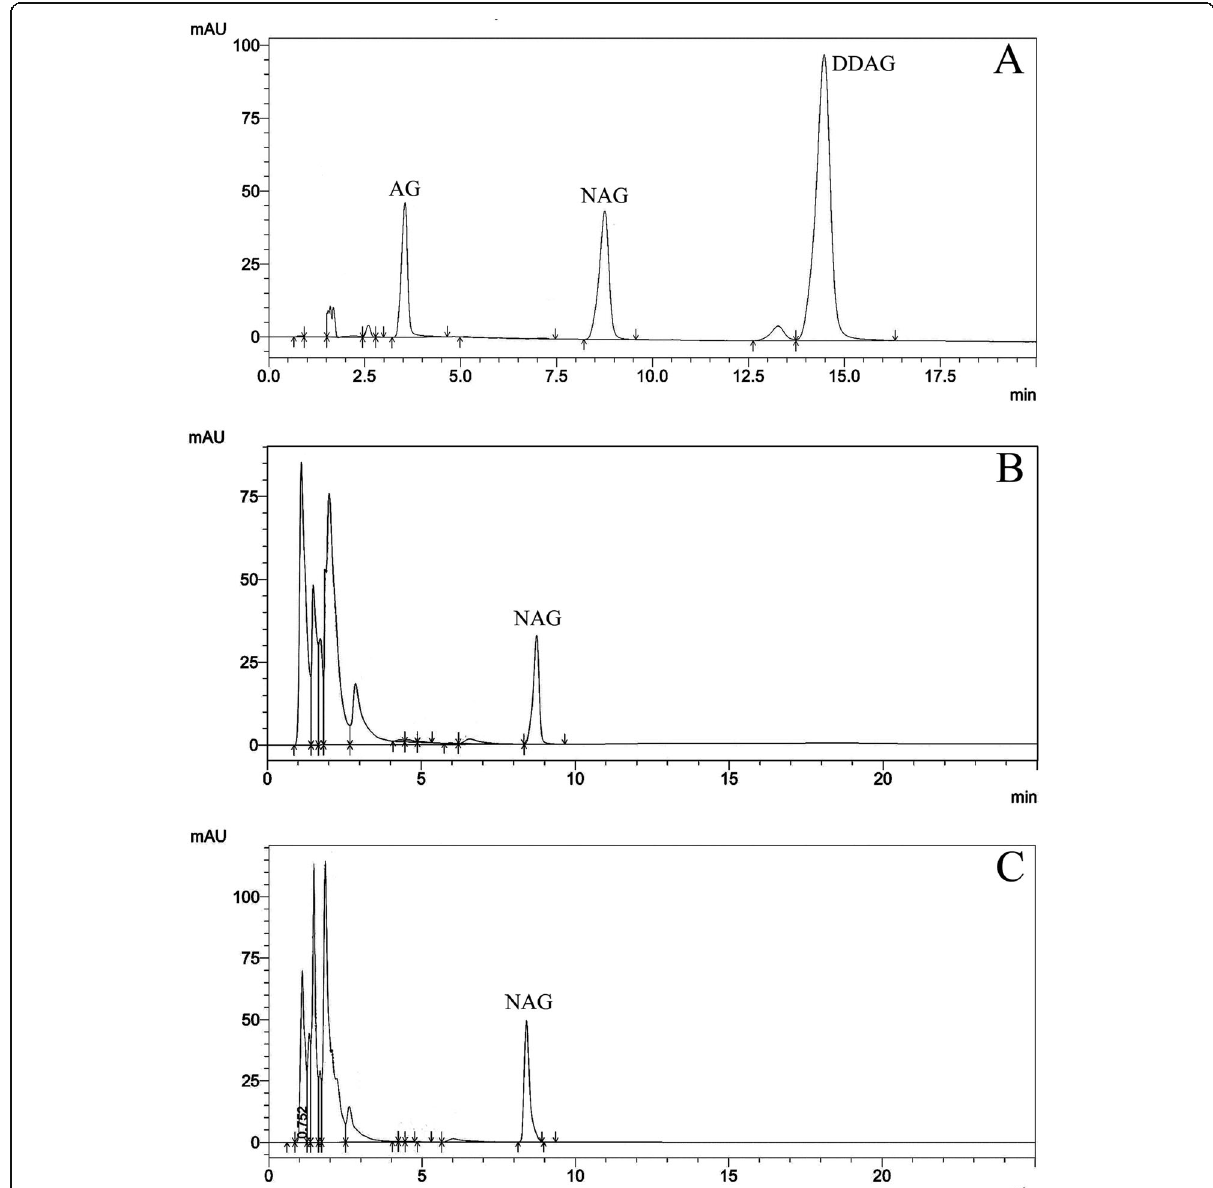
Fig. 3 RP-HPLC elution profile of neoandrographolide (standard, panel a ). RP-HPLC elution profile of neoandrographolide isolated from mother plant (panel b ). RP-HPLC elution profile of neoandrographolide isolated from in vitro regenerated plants (panel c